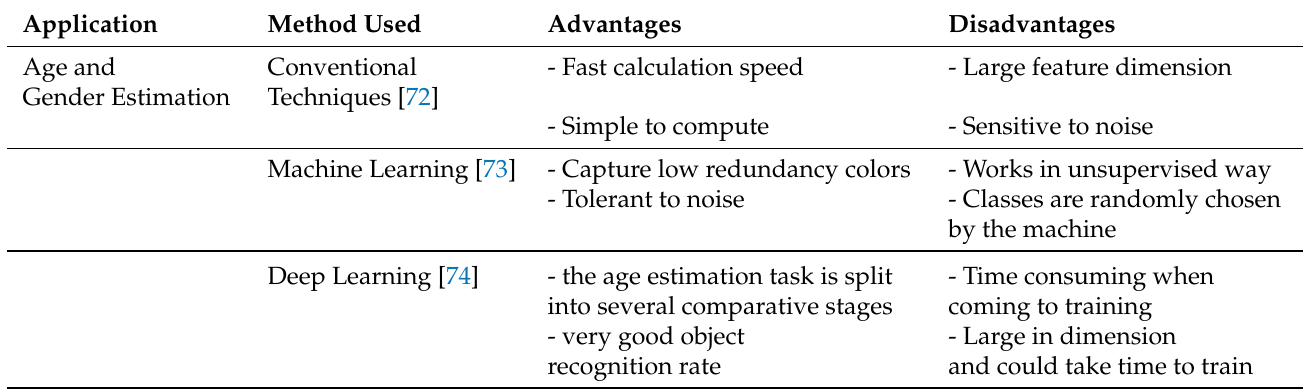
Table 7. Comparison between methods used in